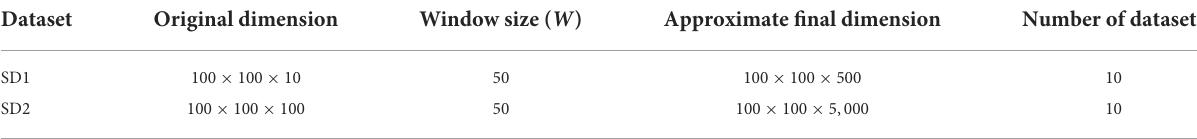
TABLE 1 Table of synthetic datasets